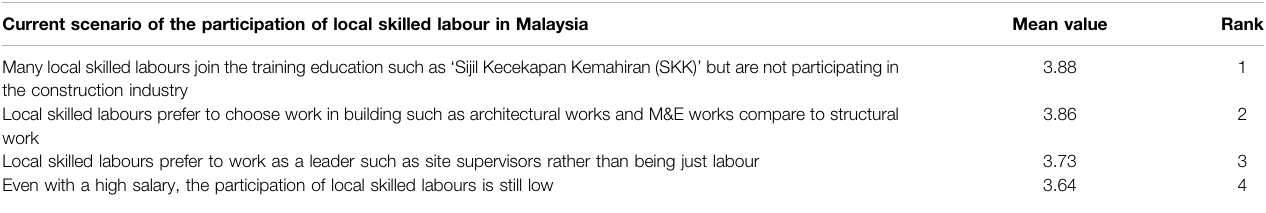
TABLE 6 | The current scenario of the participation of local skilled labour in Malaysia. Current scenario of the participation of local skilled labour in